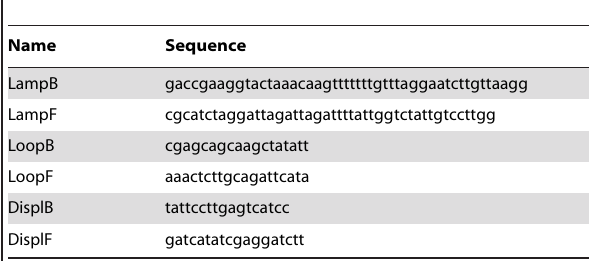
Table 3. Sequences of six ChAT